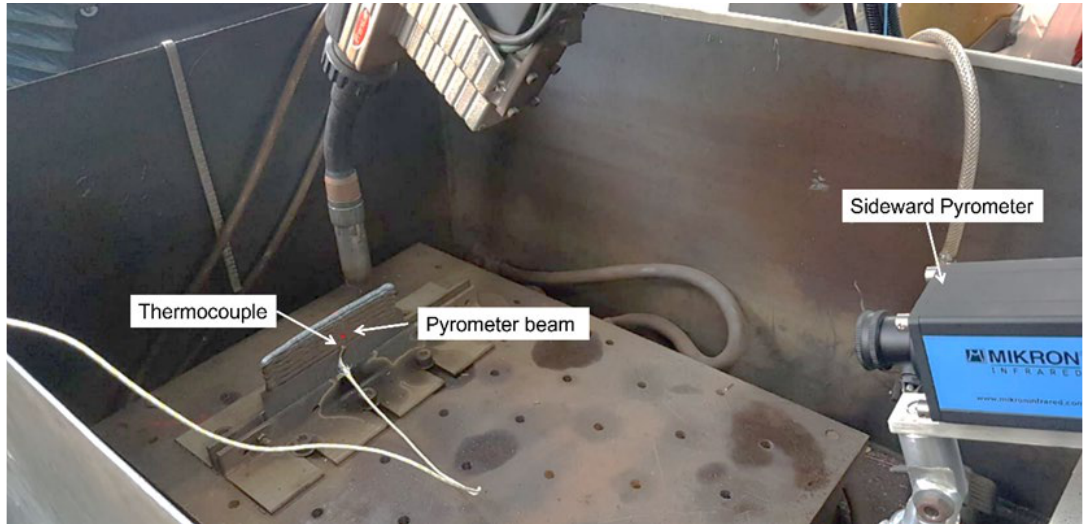
Figure 6. Experimental determination of the set emissivity coefficient (ε set ) for the sideward pyrometer approach (the heating of the measuring point is a result of 5 layers deposited on a surface at approximately 10 mm from the top edge).